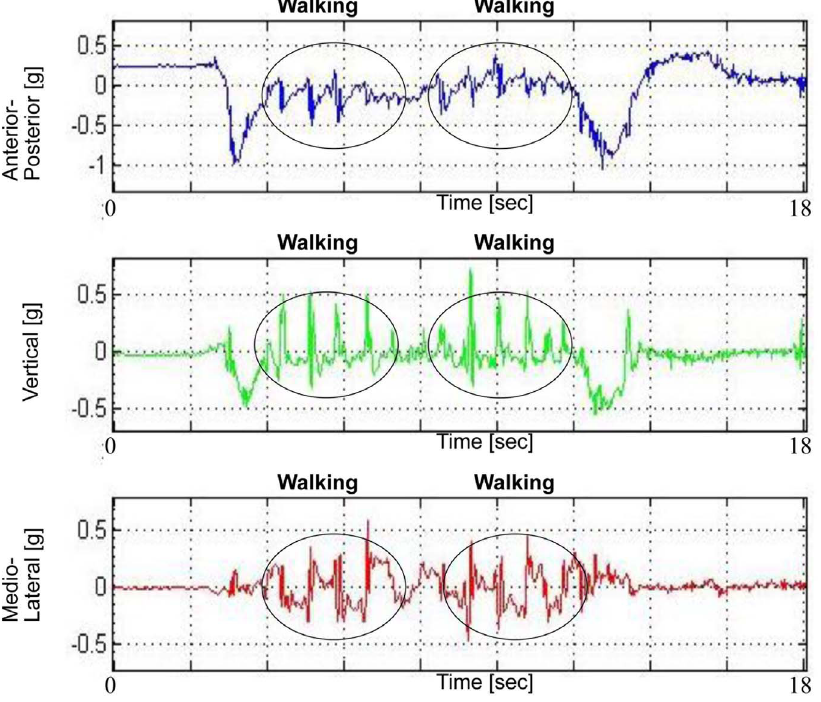
Figure 3. Walking components. Walking components derived from the anterior-posterior, vertical, and medio-lateral axes.